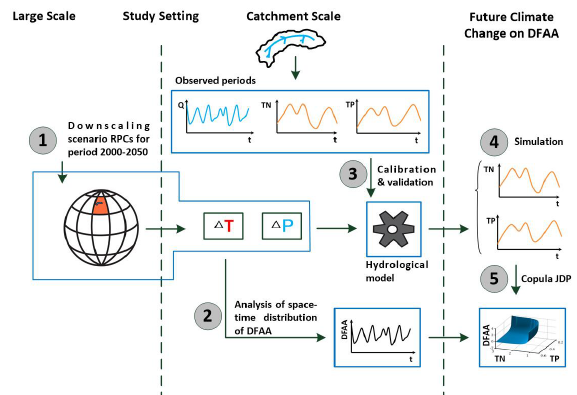
Figure 2. The framework of the impact evaluation of climate change on DFAA and water quality: (1) Selection of climate scenario and derivation of meteorological time series for future climate conditions, (2) Analysis of the spatial and temporal changes of DFAA, (3) Calibration and validation of a hydrological model, (4) Simulate TN and TP data from 1961 to 2050, (5) Calculate multivariate JPD of DFAA, TN and